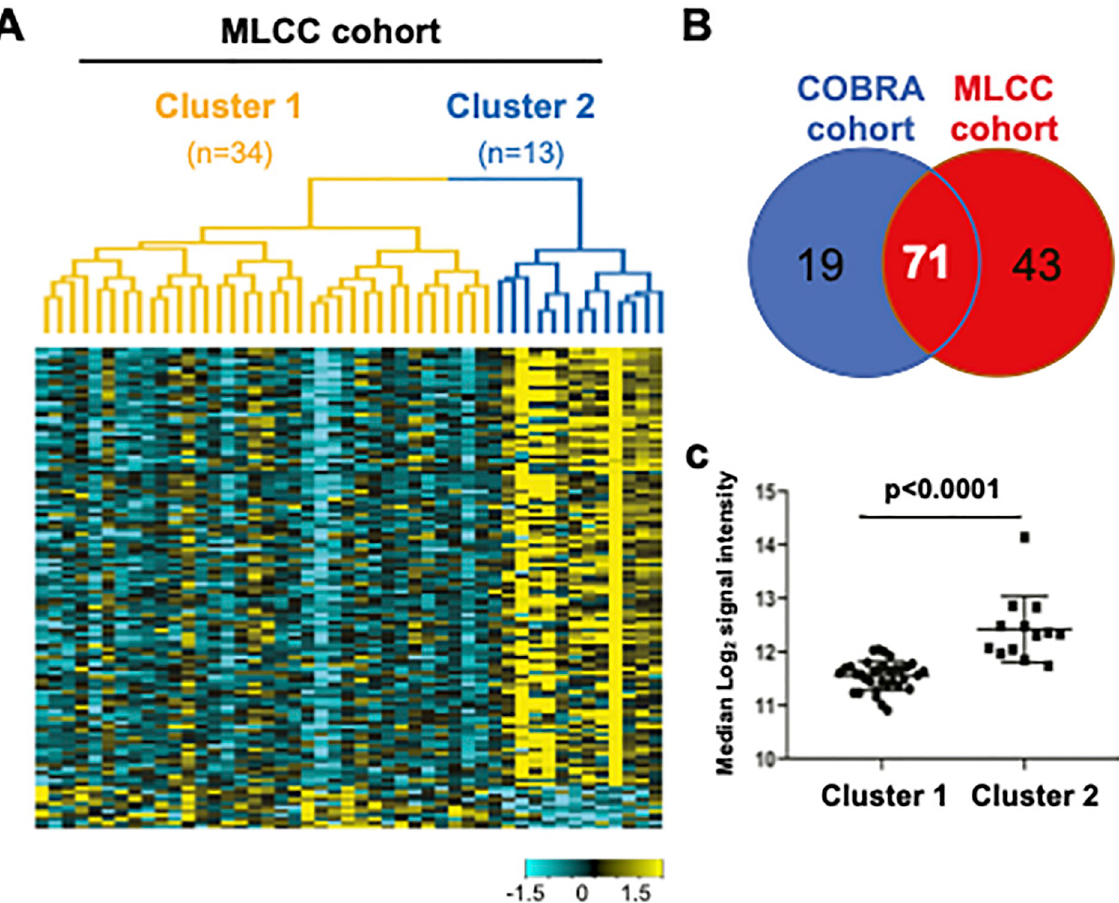
Fig 3. COPD Clusters are observed in an independent patient cohort, but not in healthy controls. (A) Heatmap showing levels of differentially expressed proteins in the MLCC cohort. Yellow indicates high expression and cyan indicates low expression. (B) Overlap of the Cluster 2-associated up-regulated proteins (Fold change > 1.5 for Cluster 2 vs Cluster 1 and FDR < 0.05) between COBRA and MLCC cohorts. (C) Protein score (defined in CORBA cohort) in Cluster 1- and 2 in the MLCC